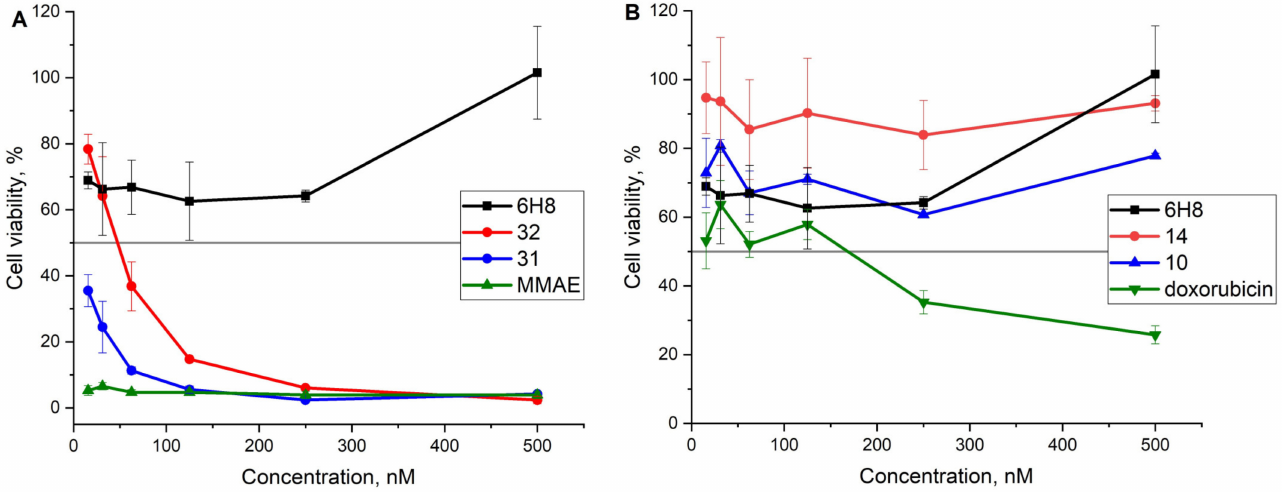
Figure 7. Viability of PRAME (+) human melanoma cell line MelP analyzed by MTT assay following 72 h incubation with 31 , 32 , MMAE, and 6H8 ( A ); 14 , 10 , doxorubicin, and 6H8 ( B ).